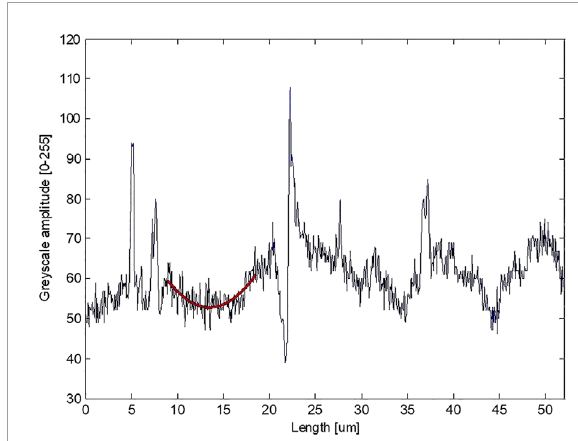
FIGURE 4 Amplitude of fluctuations measured on a longitudinal line of one of the fabric fibers (from ×1,500 SEM image resolution). Sharp peaks are observed at the junctions between cuticles, whereas fluctuations down to the smallest scales are observed. A typical baseline, restricted to a single cuticle region, is shown, and was used for detrending the signal. Sub-micrometer roughness has been evaluated by analyzing the amplitudes of the fluctuation with respect to such